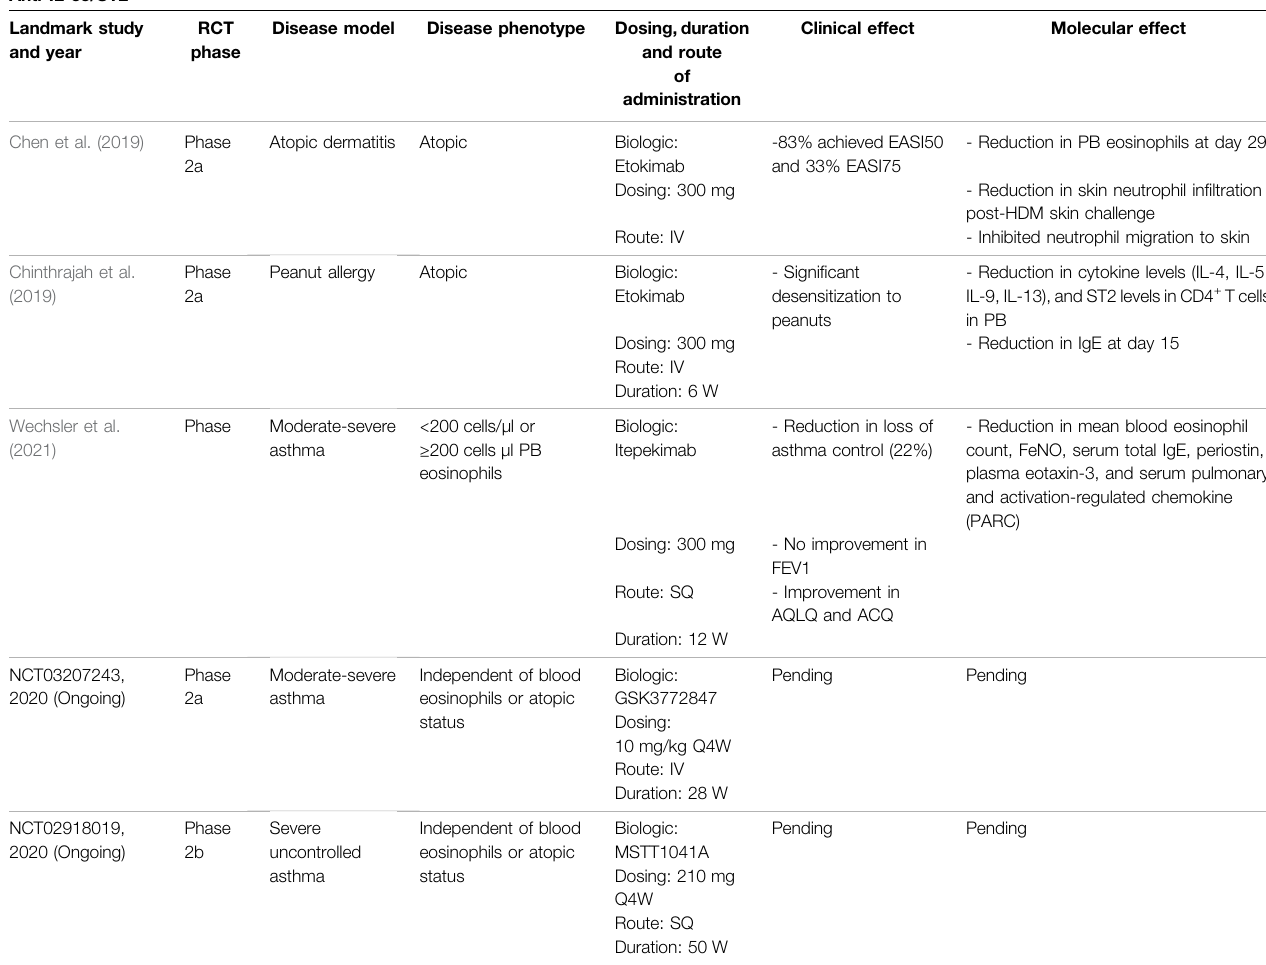
TABLE 7 | Summary of IL-33/ST2-targeted therapy in severe